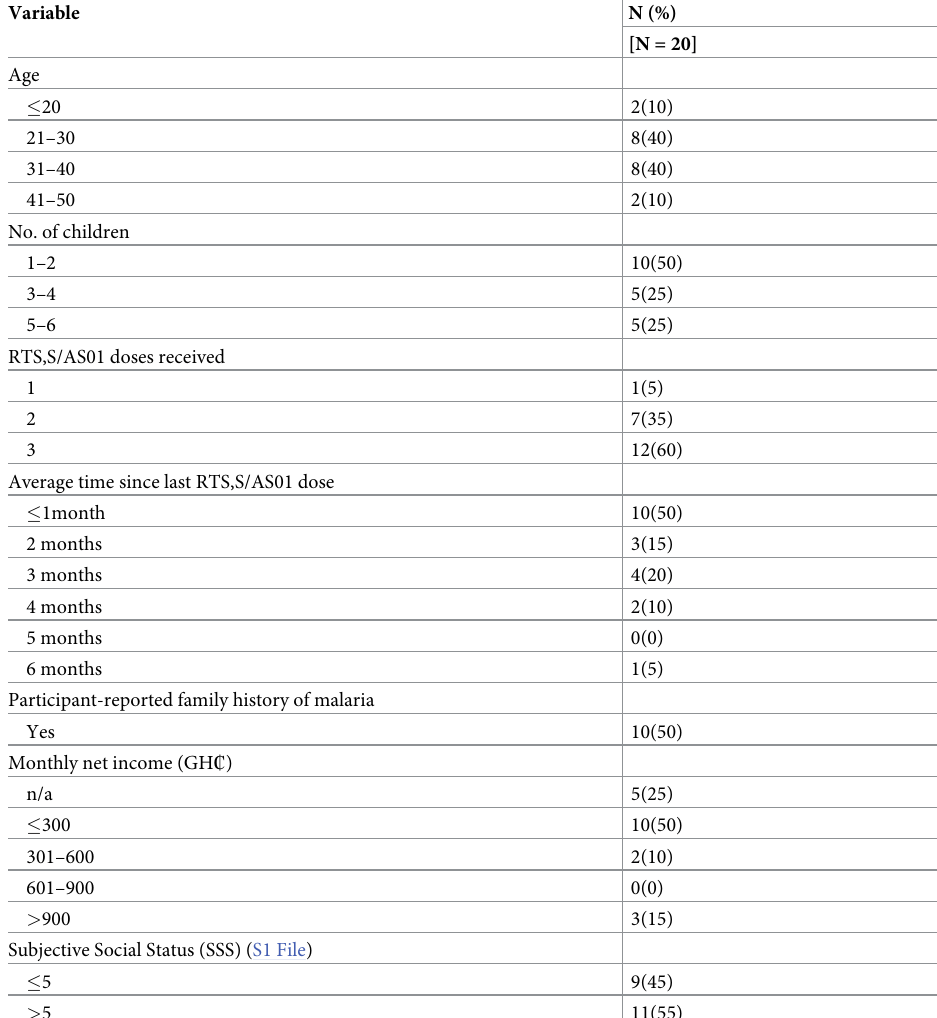
Table 1. Participant